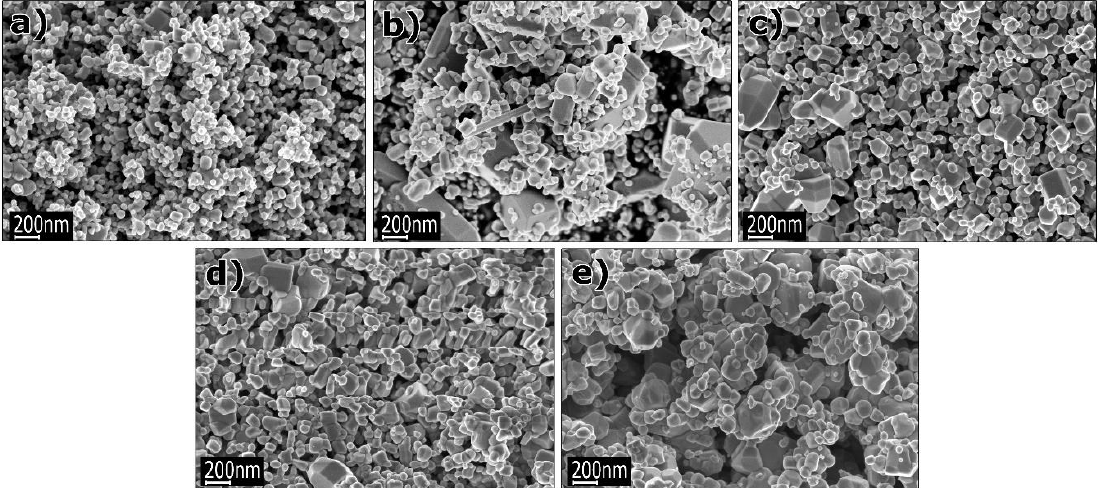
Figure 60. SEM images of annealed ZnO nanopowders after annealing at 800 °C in nitrogen: ( a ) undoped, ( b ) doped with 1 mol% of Co 2+ , ( c ) 5 mol% of Co 2+ , ( d ) 10 mol% of Co 2+ , and ( e ) 15 mol% of Co 2+ ions. Reprinted with permission from [798], Copyright © 2015 Wojnarowicz et al., Article licensed under a CC BY 2.0.